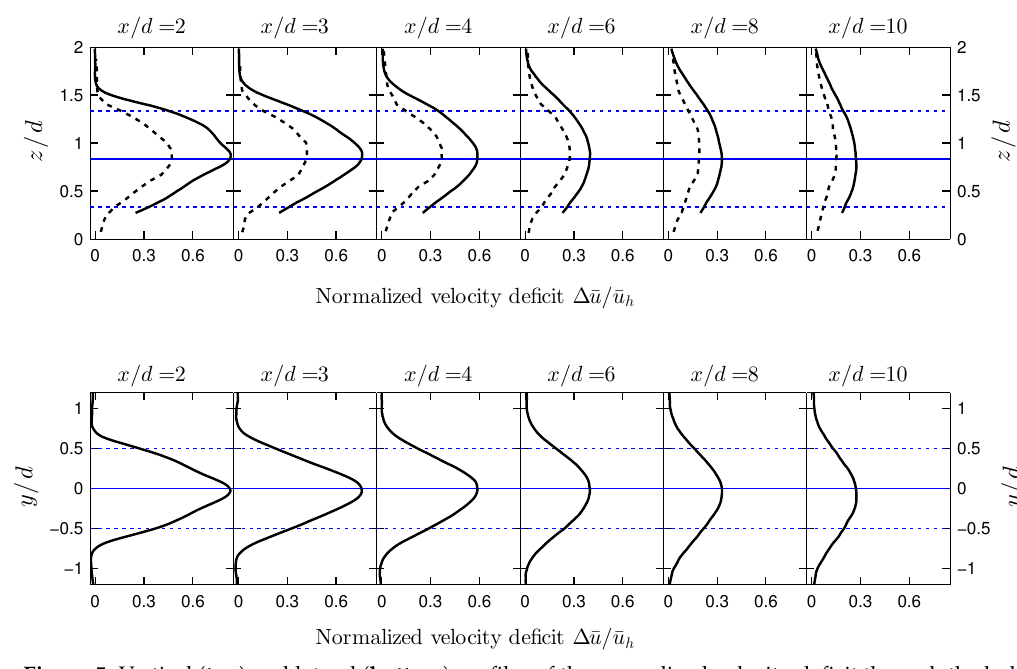
Figure 5. Vertical ( top ) and lateral ( bottom ) profiles of the normalized velocity deficit through the hub level at different downstream locations. Solid black lines: new miniature turbine, and dashed black lines: Chamorro and Porté-Agel [10]. Blue solid lines and blue dashed lines represent the rotor axis and the tip positions,